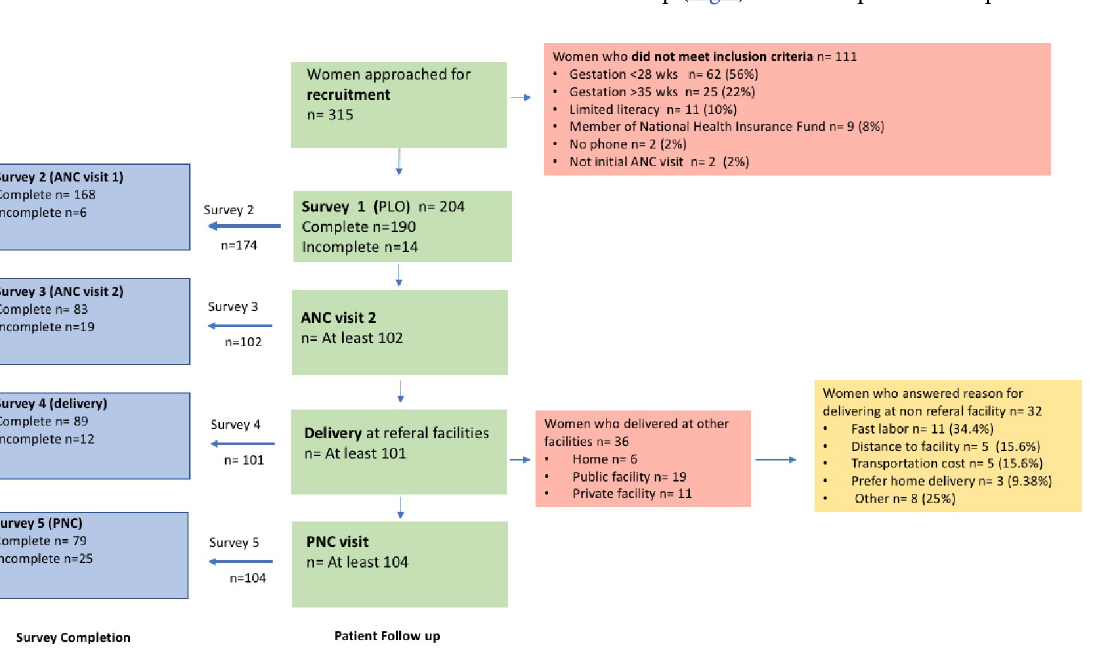
Fig 3. Selection of Standard Set domains and indicators. ICHOM PCB Standard Set domains, indicators and case- mix domains selected for pilot in Nairobi, Kenya. “Yes” indicates selection of the ICHOM indicator for pilot in Kenya.